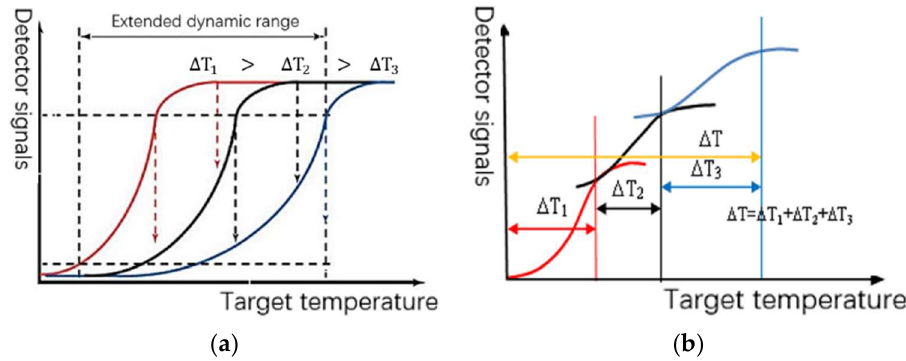
Figure 1. LDR response curve of IRFPA and its variable integration time expansion. ( a ) S-shaped response curve of IR imaging system; ( b ) expansion of response function with variable integration time.